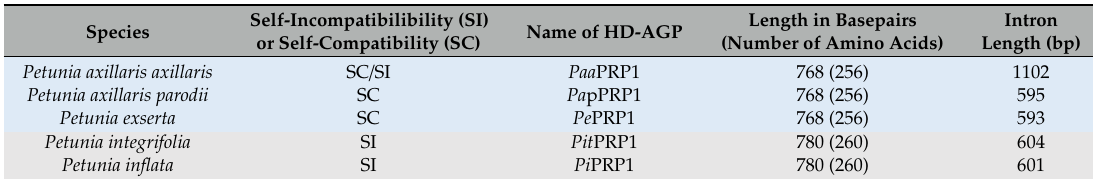
Table 1. Overview of histidine domain-arabinogalactan proteins (HD-AGPs) from five species and sub-species of wild Petunia . All the petunias shaded in blue hybridize readily in the greenhouse to produce large capsules and seed set comparable to those from conspecific matings. The species shaded in grey readily hybridize with each other in the greenhouse to produce large capsules and seed set comparable to those from conspecific matings. The species shown in blue versus grey are reproductively isolated from each other by SI-related IRBs or incongruity, depending on the direction of the cross. All Petunia HD-AGP s identified so far contain a single intron at the same location (near the beginning of the PAC